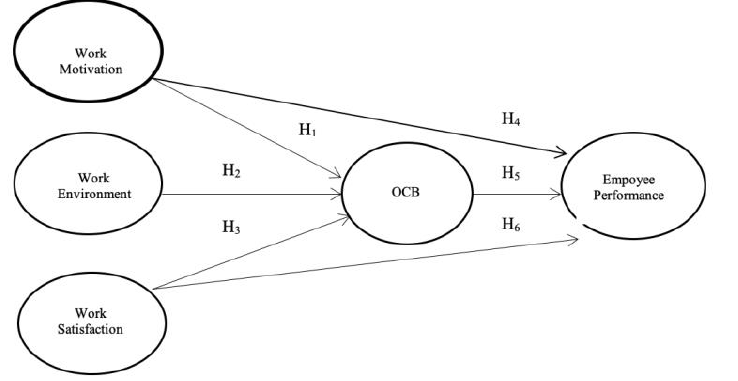
Figure 1 : The construct & dimension of the research